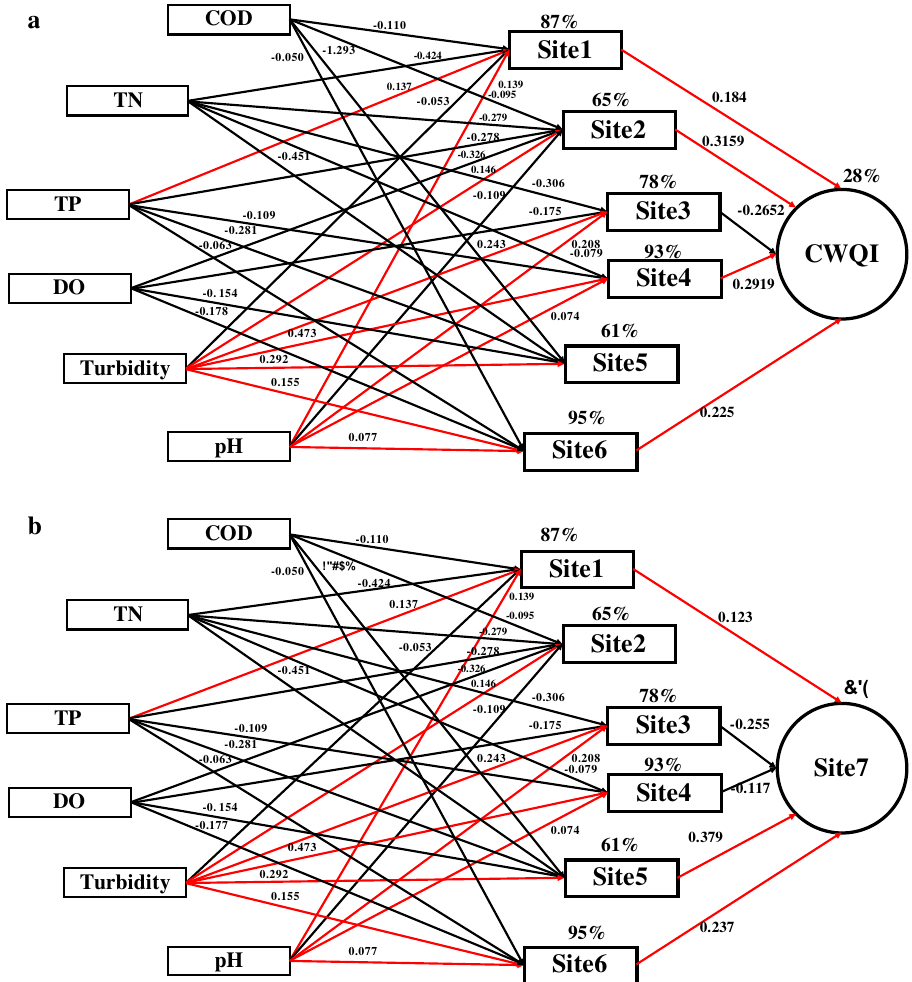
Figure 4. Linear mixed models (LMM) coupling selected water quality parameters and CWQI at main river. Regression R 2 values from the permutation test were presented on the arrows, which were all significant ( P < 0.050). Black arrows represented negative paths, and red arrows represented positive